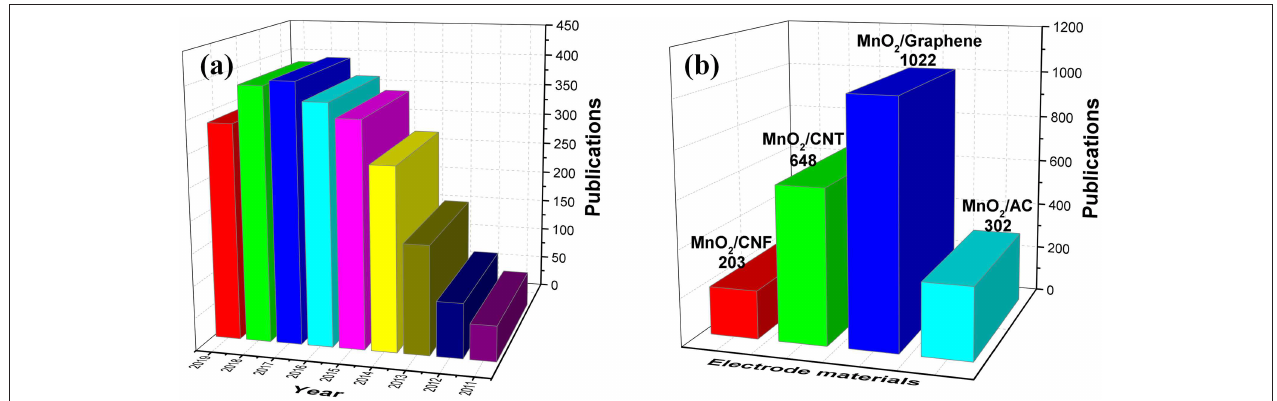
FIGURE 2 | Statistical survey of research papers on MnO 2 /carbon composites for supercapacitors. (a) Total number of related reports from 2011 to 2019. (b) Literature statistics for different types of carbon materials/MnO 2 composites. Source: Web of Science. Search date: August 20, 2019.